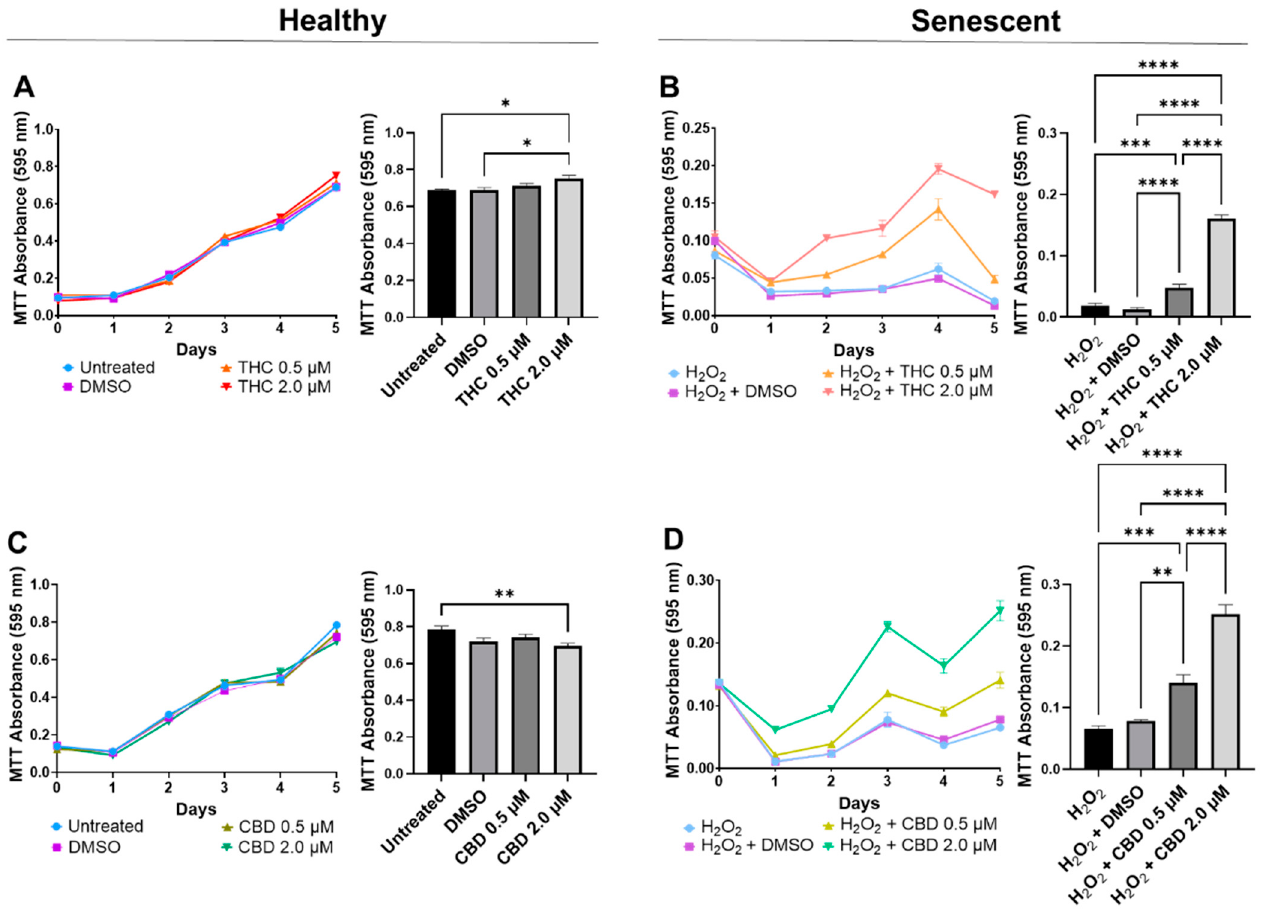
Figure 2. Cell viability of CCD-1064Sk human dermal fibroblasts (PDL 24) treated with THC or CBD at concentrations of 0, 0.5, or 2 µM. ( A ) Healthy fibroblasts treated with 0, 0.5, or 2 µM of THC. ( B ) SIPS fibroblasts treated with 0, 0.5, or 2 µM of THC. ( C ) Healthy fibroblasts treated with 0, 0.5, or 2 µM of CBD. ( D ) SIPS fibroblasts treated with 0, 0.5, or 2 µM of CBD. Cell viability was quantified by MTT assay. Data were analyzed with an ANOVA test followed by Tukey’s post-hoc multiple comparison test. Bars represent mean ± SEM, n = 3. Significance is indicated using the following scale: * p < 0.05, ** p < 0.01, *** p < 0.001, **** p < 0.0001. CBD, cannabidiol; DMSO, dimethyl sulfoxide (vehicle); THC, delta-9-tetrahydrocannabinol.